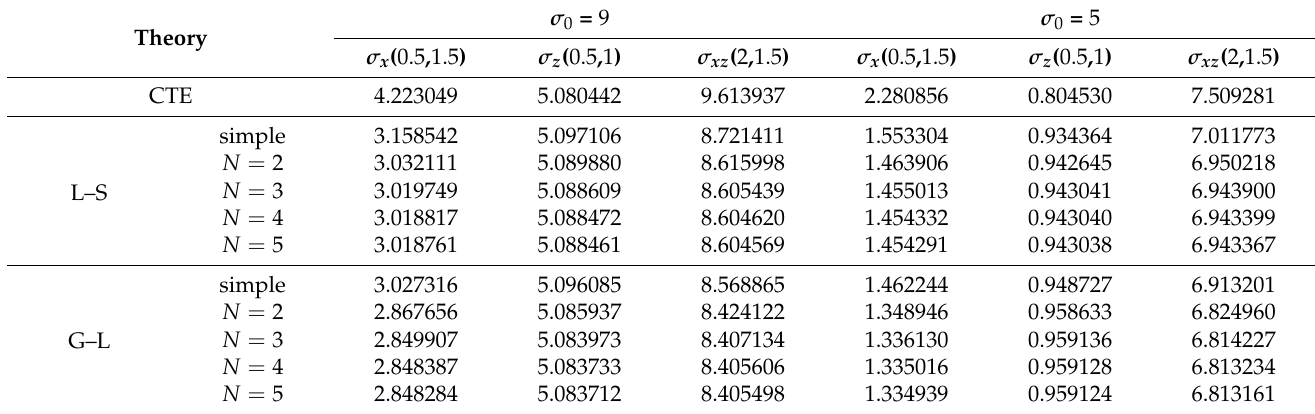
Table 2. Effect of initial stress σ 0 on the stresses of the rotating half-space with initial pressure ( (cid:112) = 10).